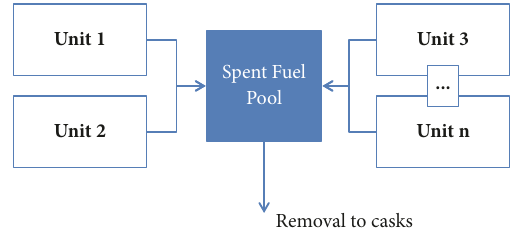
Figure 4: Flow of fuel assemblies in and out of a spent fuel pool shared by the n units of a